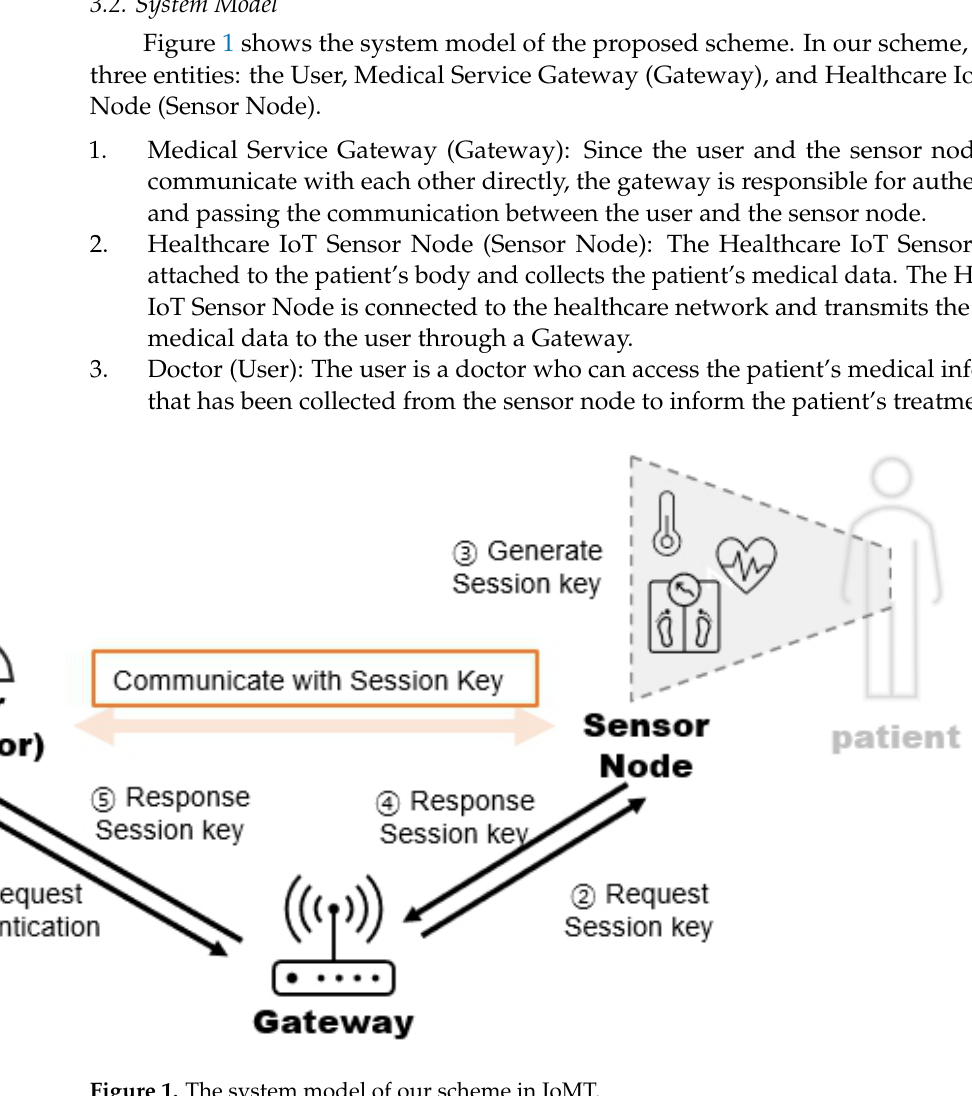
Figure 1. The system model of our scheme in